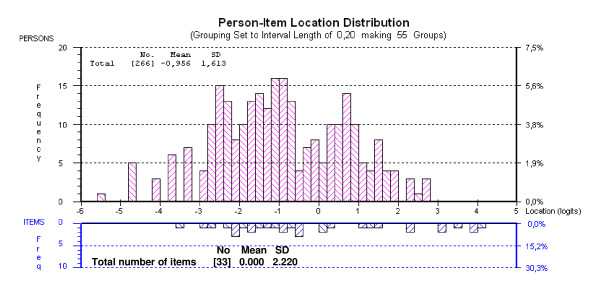
Targeting of "Body Functions" item bank to patient disability (after collapsing of the categories). (n = 266).